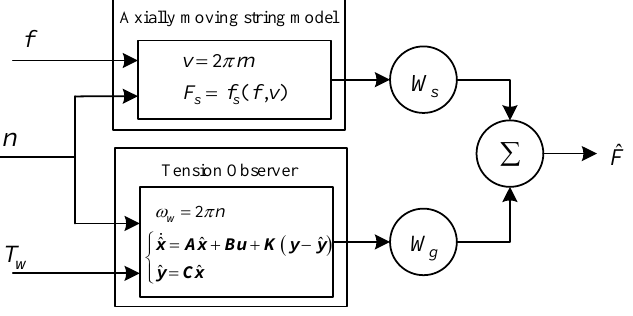
Figure 3. Diagram of the tension observer principle block.